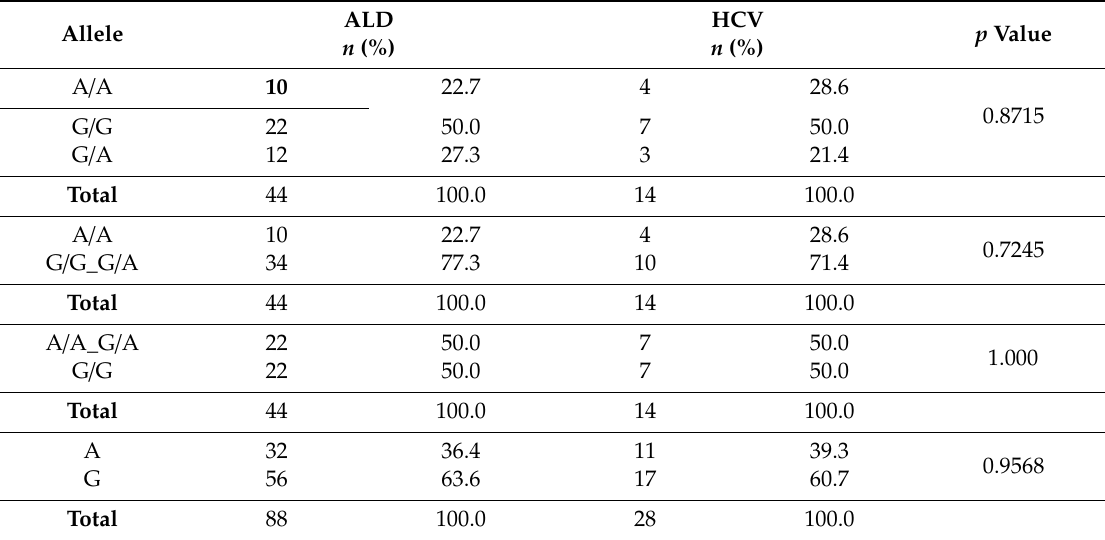
Table 5. Allele Frequencies Compared to Alcoholic liver disease (ALD) / hepatitis C virus (HCV) Groups—SNP rs4893819 (-1275 G >